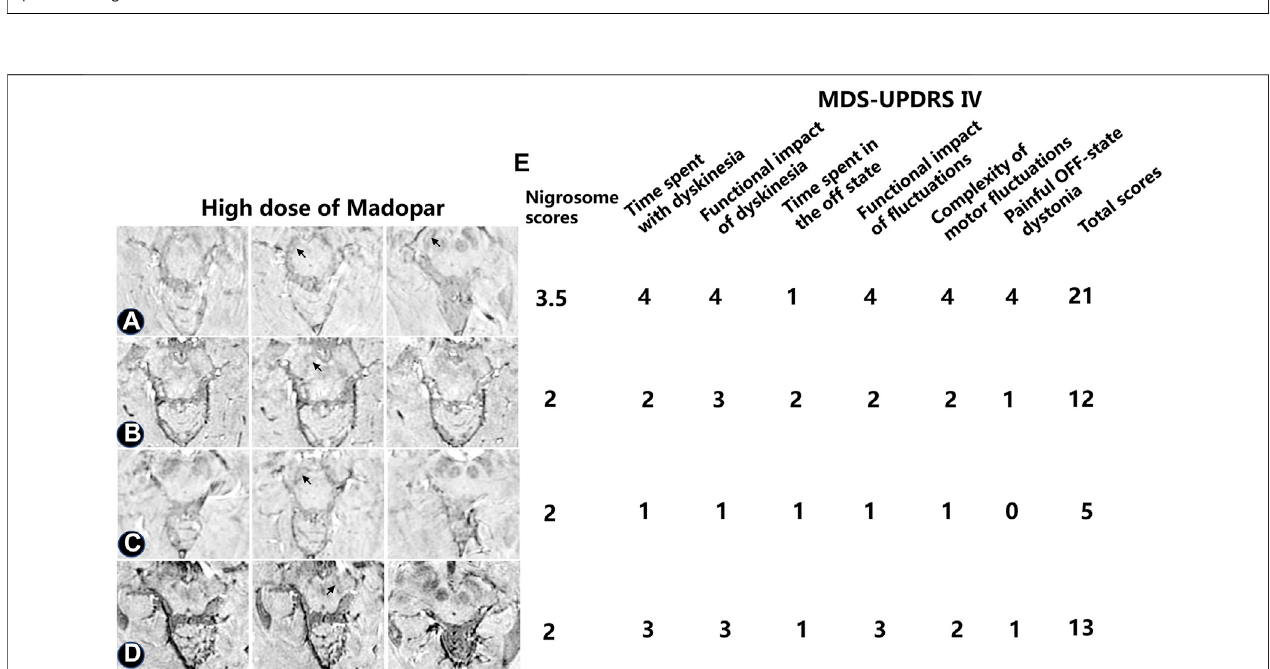
FIGURE5| Comparisoninthealterationsinironaccumulationinthenigrosomeinthepretreatmentandposttreatmentgroups. (A) Thealterationsinirondeposition in the nigrosome were evaluated in two of the patients after treatment for 10 months. (B) Nigrosome scores and UPDRS Ⅲ scores were observed after receiving pharmacological treatment.